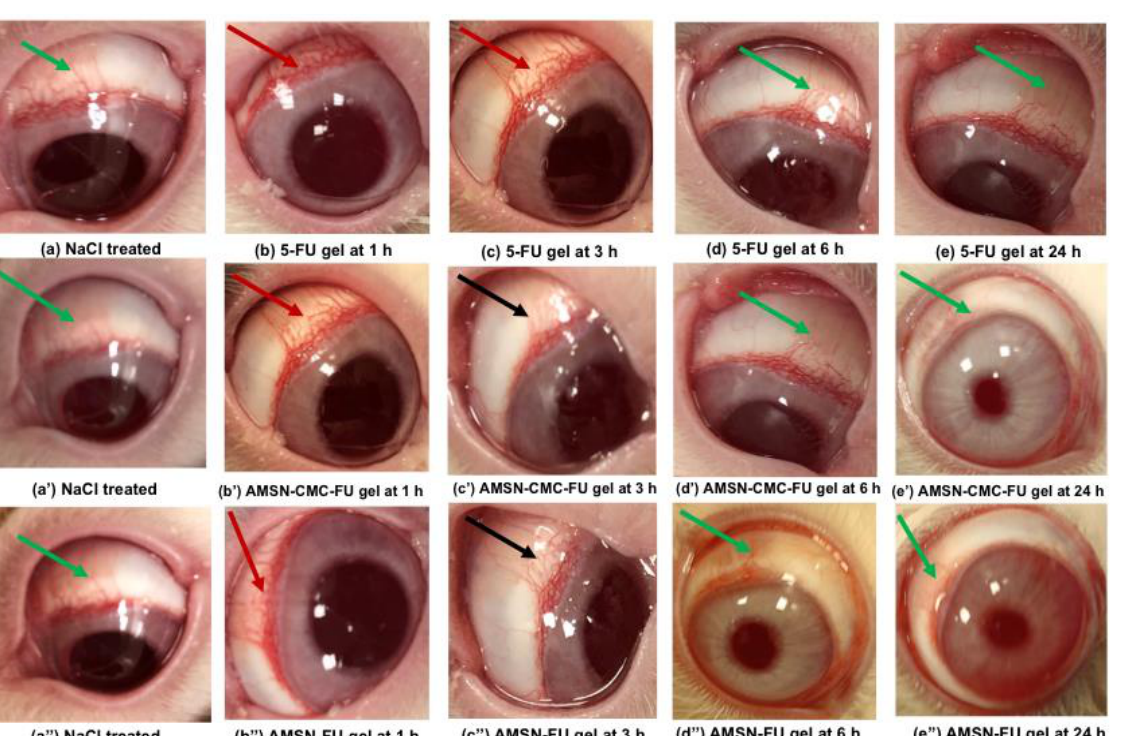
Table 5. Calculation of Maximum Mean Total Score (MMTS) by considering the obtained scores. 5-FU Gel In rabbit